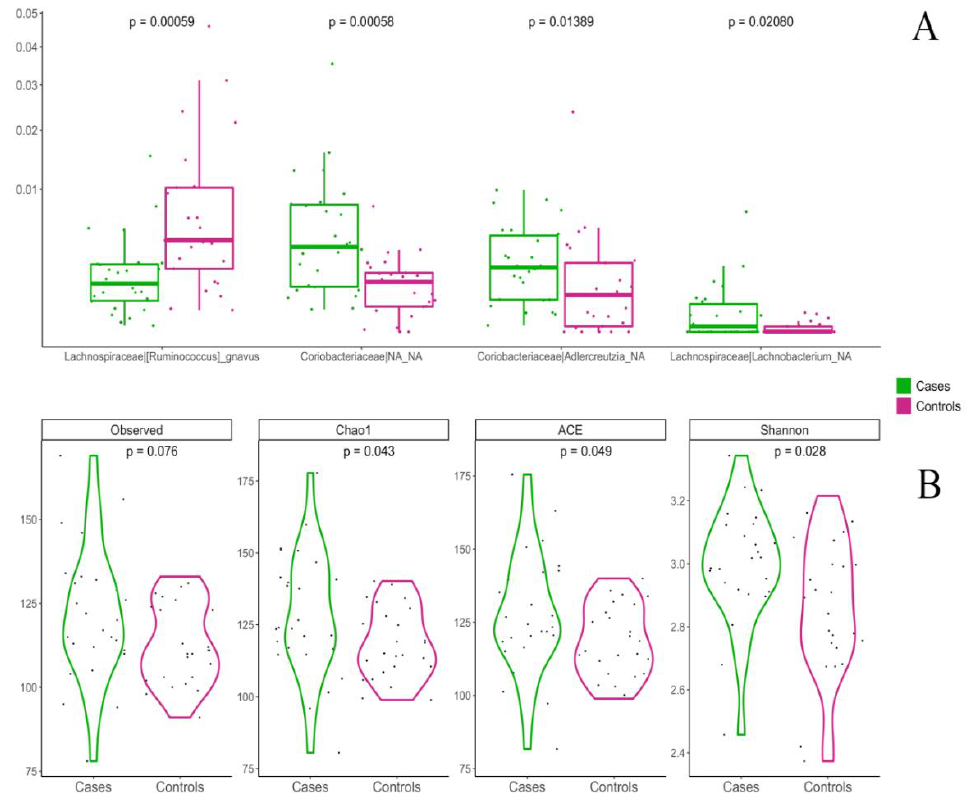
Figure 5. Boxplots showing the relative abundance of microbial taxa between the Med Diet group (green) and controls (pink). ( A ): boxes represent the interquartile range (IQR) between the first and third quartiles and the line inside represents the median (2nd quartile). Whiskers denote the lowest and the highest values within 1.5 × IQR from the first and third quartiles, respectively. Between groups differences were assessed by applying pairwise Wilcoxon test. ( B ): Violin plots showing the difference in four alpha-diversity indices between the Med Diet group and controls. Wilcoxon’s rank sum test was used to assess the significance.